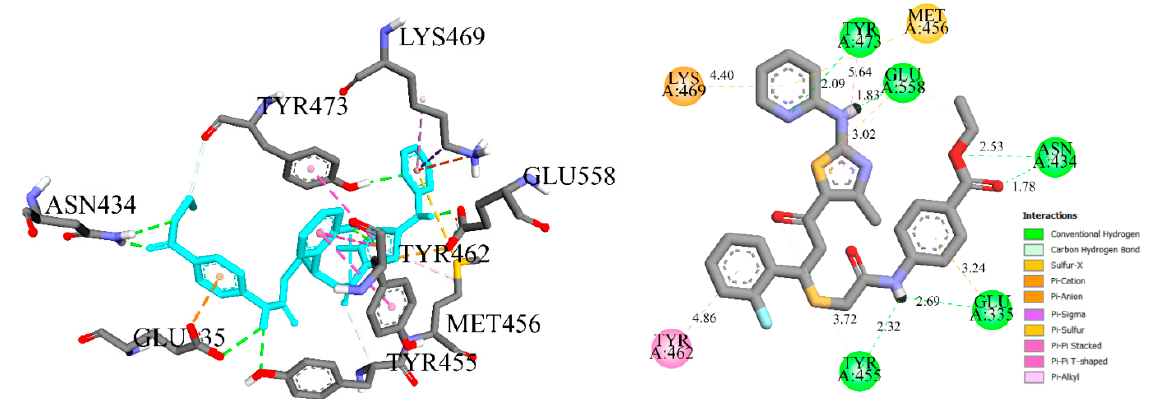
Figure 20. The binding of compound 4 best-generated conformer with the PARP2 (PDB 4PJV).